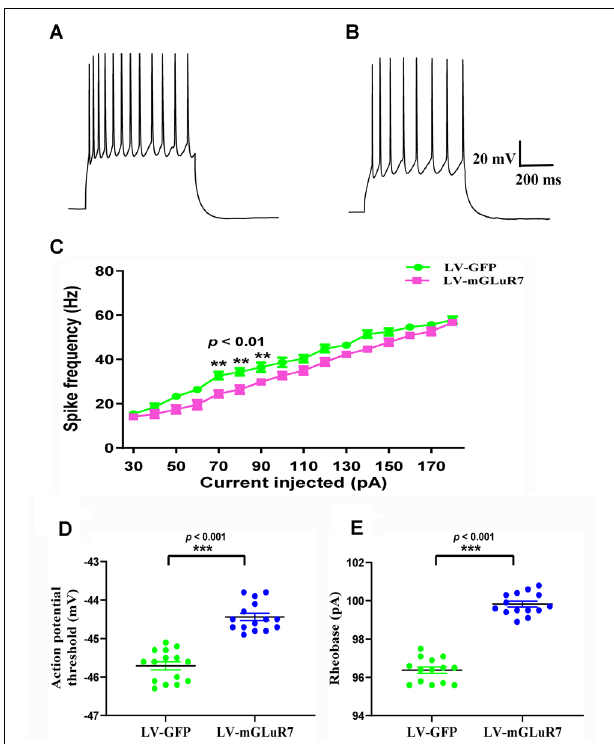
FIGURE 5 | In vitro whole-cell recordings revealing the impact of mGluR7 on neuronal excitability in PFC slices. (A,B) Representative GFP-positive and mGluR7-expressing neurons traces corresponding to firing frequencies following the intracellular injection of step currents in mice exposed to VPA administered LV-GFP or LV-mGluR7. (C) Evoked spike rates vs. pyramidal cell current magnitudes in the PFC in the two treatment groups, exhibiting a significant reduction in mean firing frequency in LV-mGluR7-injected mice relative to controls ( F (1,28) = 11.023, p < 0.01; F (1,28) = 10.058, p < 0.01; F (1,28) = 8.129, p < 0.01). n = 8 animals per group. ** p < 0.01; repeated measures ANOVA. Data are means ± SEM. (D,E) The action potential threshold of LV-mGluR7-exposed mice was significantly higher than those of LV-GFP-treated mice ( p < 0.001). The rheobase of LV-mGluR7-exposed mice was significantly greater than those of controls ( p < 0.001). n = 7 animals in each group. *** p < 0.001; Student’s t -test. Data are presented as means ±